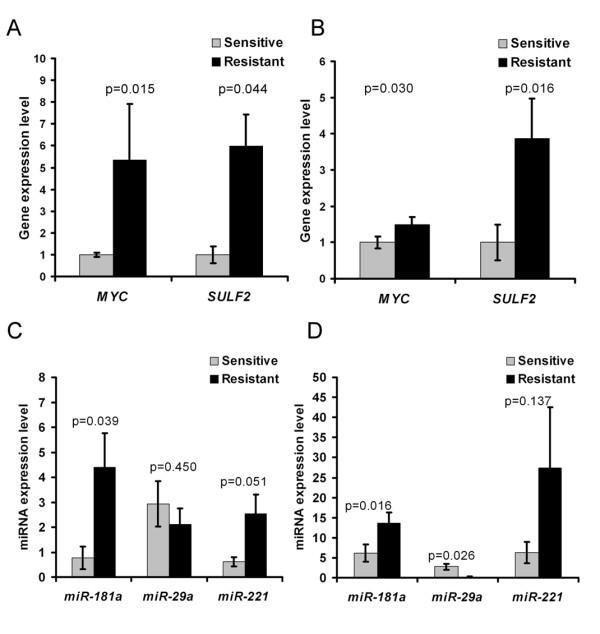
Relationship between gene expression before treatment and sensitivity to fludarabine in CLL patients. Expression levels of the targets were investigated by RT-qPCR and normalized to both housekeeping genes. The average expression level in sensitive patients was used as calibrator. Expression levels presented as mean values ±SEM were investigated on two groups of CLL patients; eighteen patients in vivo (8S and 10R) and twenty-one patients in vitro (16S and 5R). Statistical analysis was performed by 2-sided t-test and levels were considered to be significantly different when p values were lower than 0.05. A and B. The expression of MYC and SULF2 was measured in CLL B cells of patients before their treatment with fludarabine in vivo (A) and in vitro (B). C and D. The expression of miR-29a, miR-181a, and miR-221 was investigated in CLL B cells of patients before their treatment with fludarabine in vivo (C) and in vitro (D).